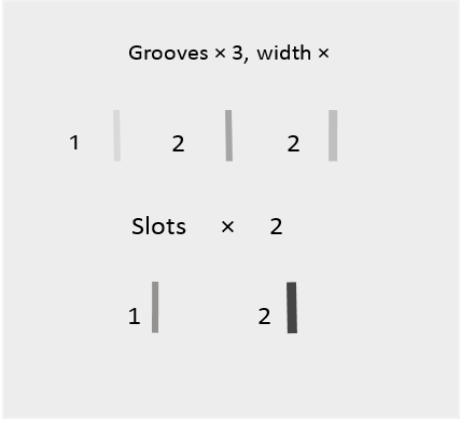
Figure 2. Size of grooves and slots machined [19].